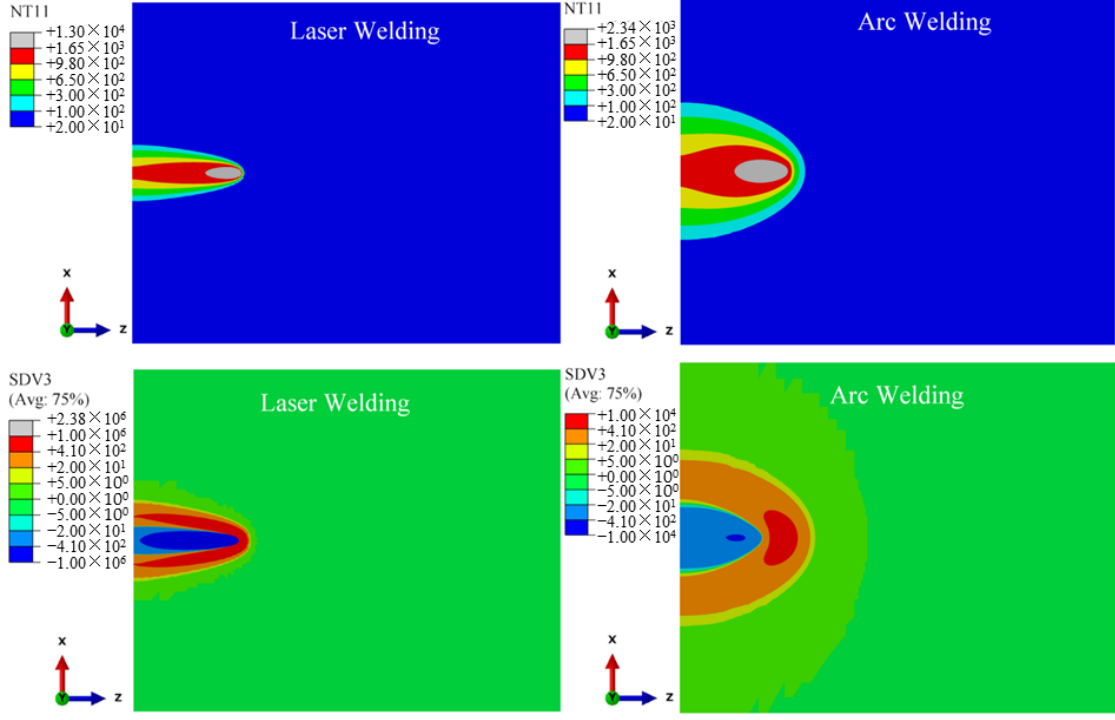
Figure 15. 25 mm from starting position, changes of current temperature NT11( ◦ C) and cool- ing/heating rate SDV3( ◦ C/s) during